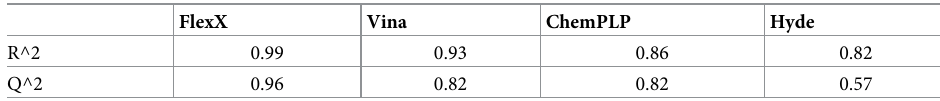
Table 1. R^2 and Q^2 values for ML-QSAR Random Forests modeling of docking scores.